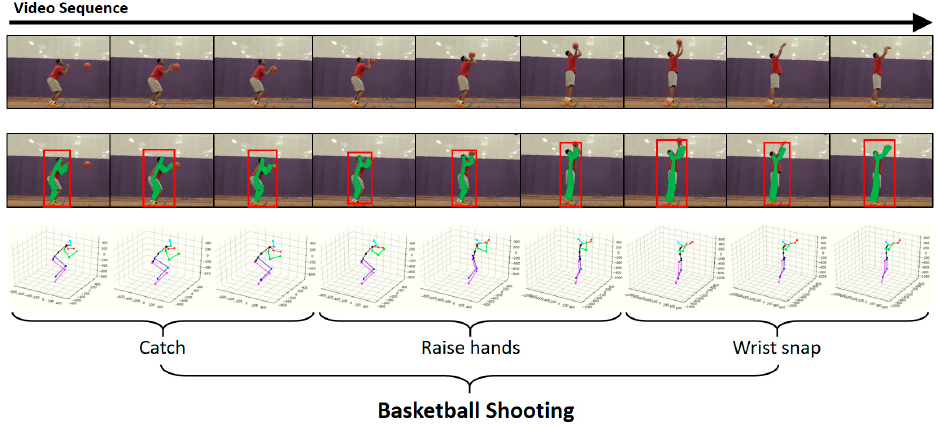
Figure 5. Pose estimation and action detection.